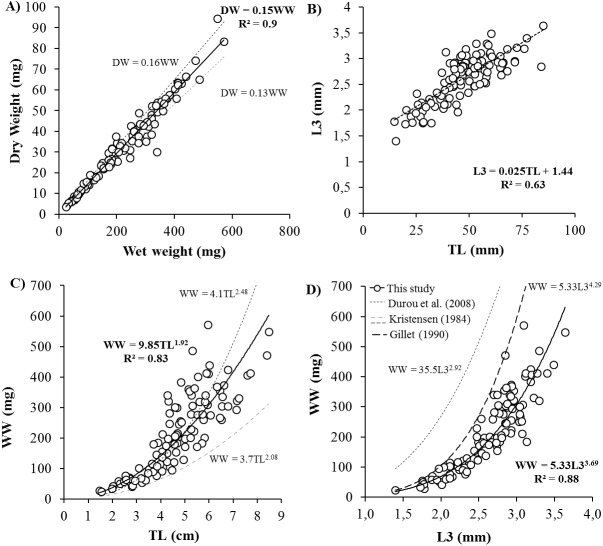
Biometric measurements relationships for Hediste diversicolor.Key relationships for Hediste diversicolor between body weight and length: (A) dry vs. wet weight (DW vs. WW), (B) length of three first segments vs. total length (L3 vs. TL), (C) WW vs. TL and (D) WW vs. L3. R2 is the determination coefficient in (A, B) as linear relation y = ax and in (C, D) as power law y = axb represented by continuous lines. Size-weight relationships described by Durou, Mouneyrac & Amiard-Triquet (2008), Kristensen (1984) and Gillet (1990) for H. diversicolor.